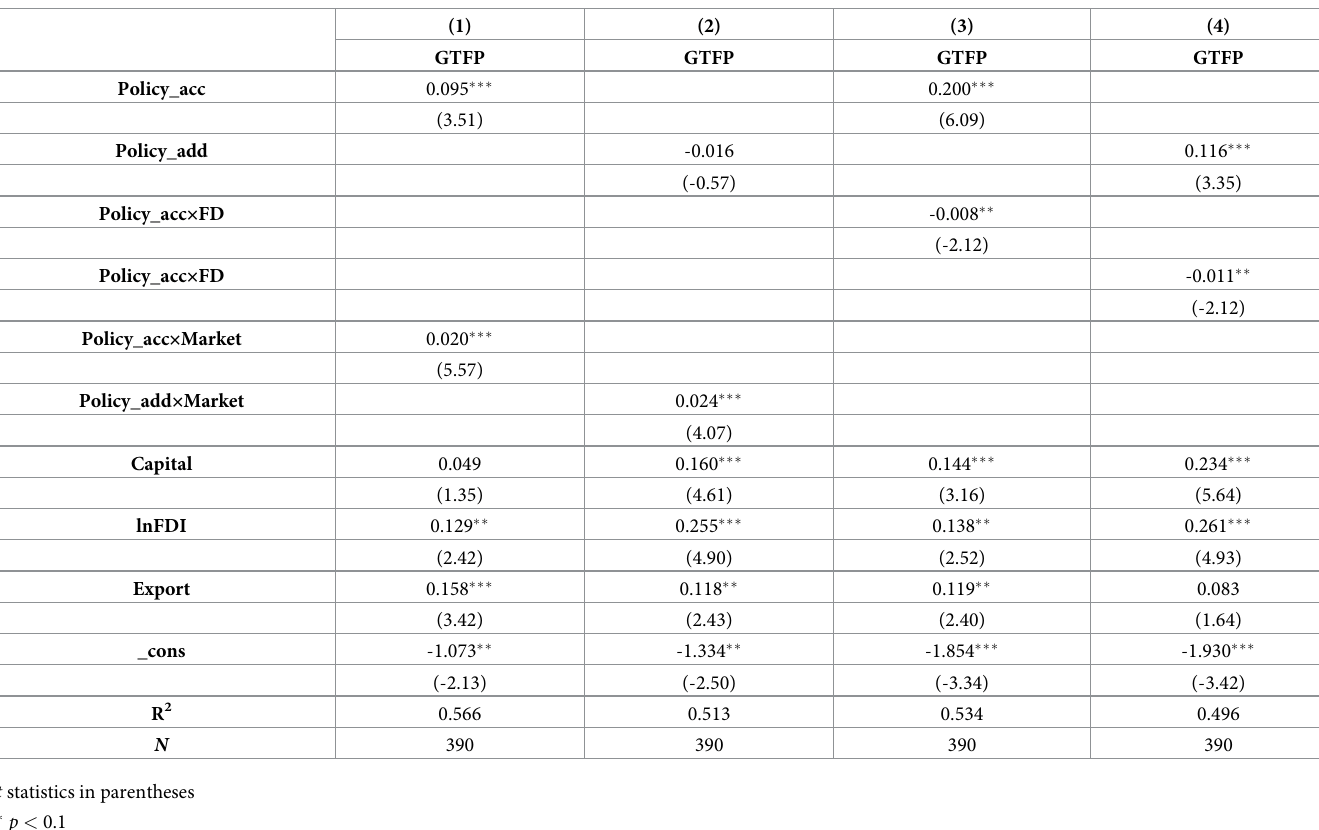
Columns (1) and (2) of Table 5, the regression results after adding the multiplication term between the policy and market variables are displayed. Regardless of whether the industrial Table 5. Moderating effect of institutional